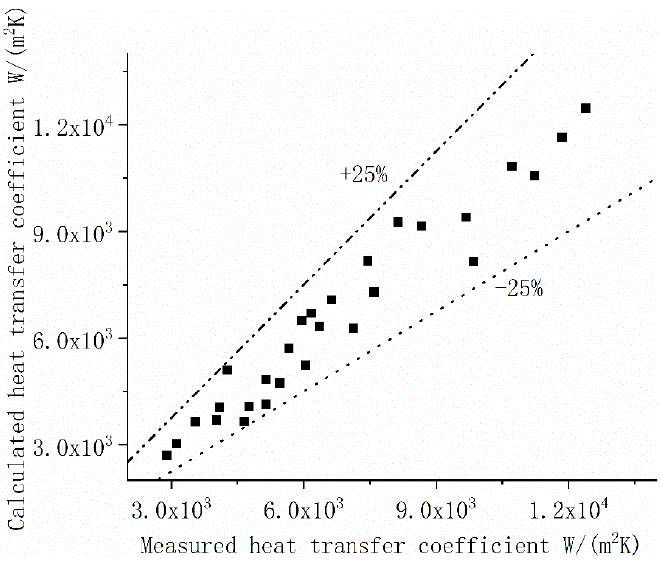
Figure 10. The calculated heat transfer coefficients agree with the measured ones.